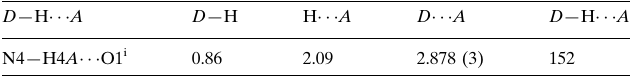
Hydrogen-bond geometry (A˚ , (cid:1)